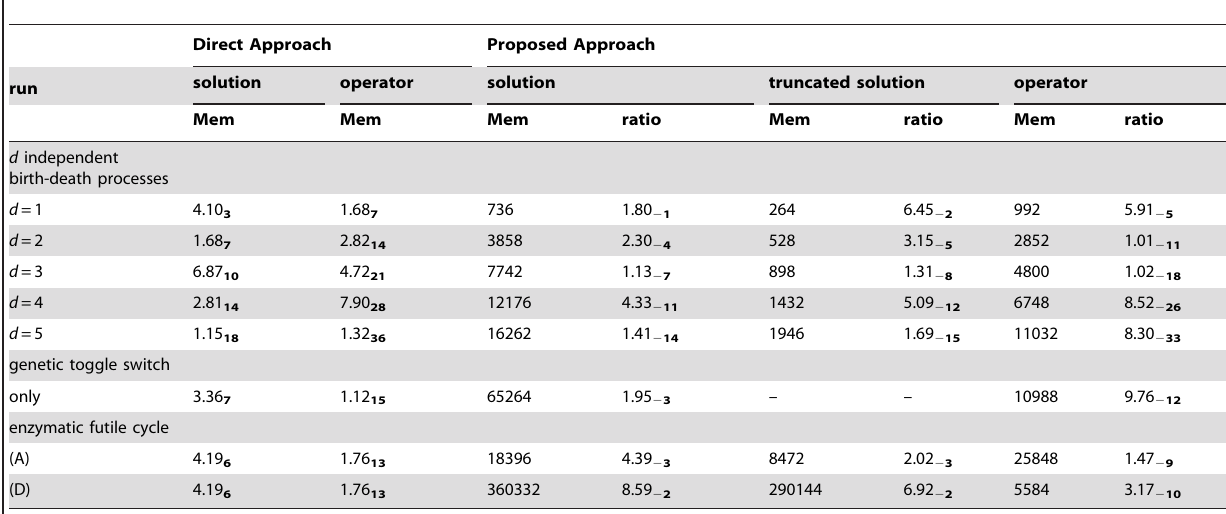
Table 1. Overview of the QTT compression of the storage needed for solutions (maximum throughout the time stepping) and CME